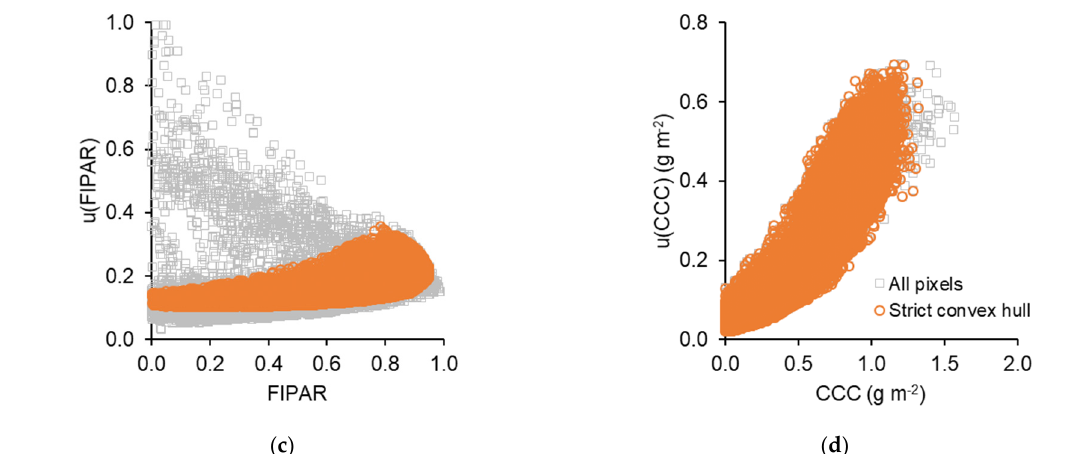
Figure A1. Comparison between pixel values and associated uncertainties for the high-spatial-resolution reference maps of FIPAR ( left ) and CCC (right ) at Las Tiesas–Barrax ( a , b ) and Wytham Woods ( c , d ). The coloured points represent pixels lying within the multispectral convex hull of the sampled ESUs (i.e., where the transfer function is not extrapolating).